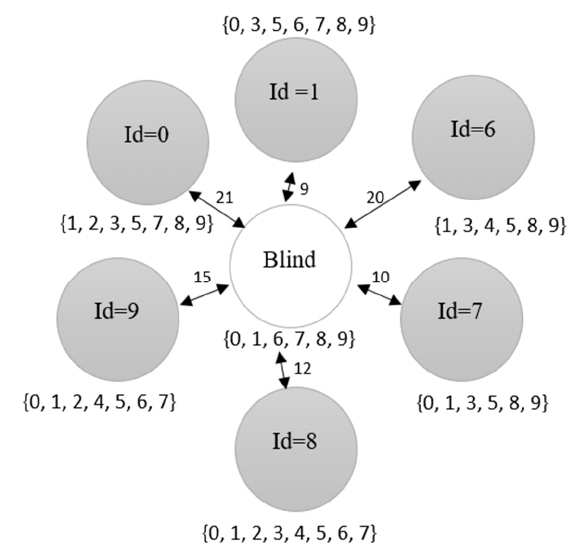
Figure 3. Example scenario of a blind node surrounded by a set of neighboring nodes. Each node has its own neighbor set. The arrows show the distance in meters ( m ) between the neighboring nodes and the blind node.